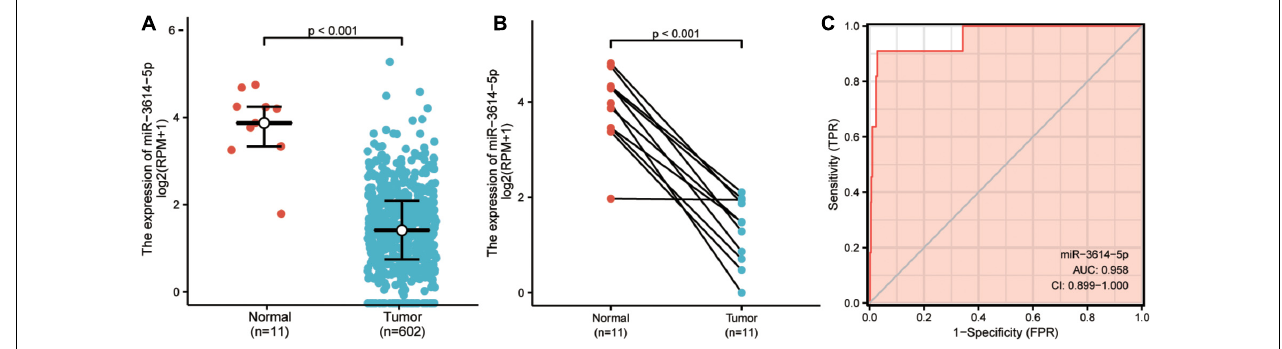
FIGURE 1 | The expression and diagnostic value of miR-3614-5p in colorectal tissues. (A) miR-3614-5p showed significantly lower expression in cancer tissues than in normal tissues. (B) miR-3614-5p was prominently lowexpressed in colorectal cancer ( P < 0.001) compared with 11 pairs non-cancerous adjacent tissues. (C) Receiver Operating Characteristic Curve, FPR, False Positive Rate; TPR, True Positive Rate; CI, Confidence interval.